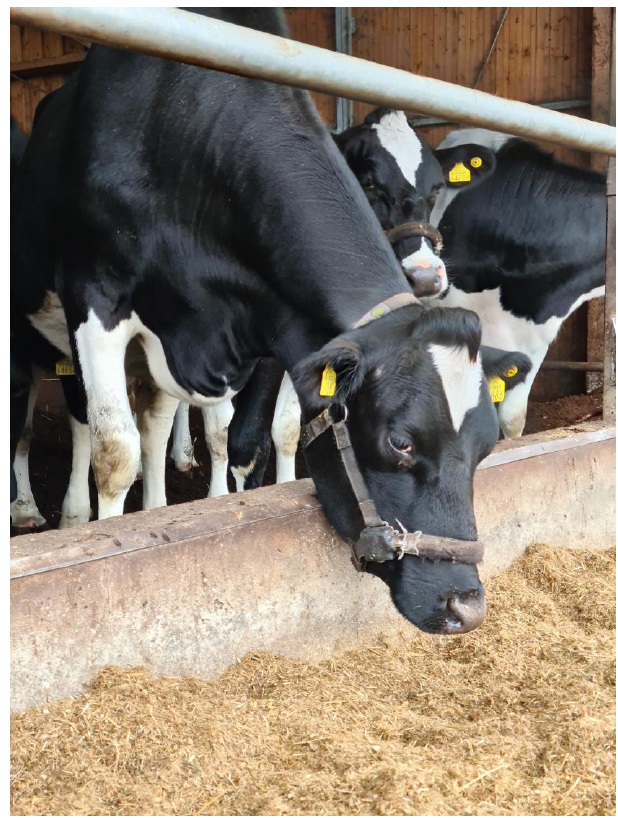
Figure 1. Cow with the RumiWatch